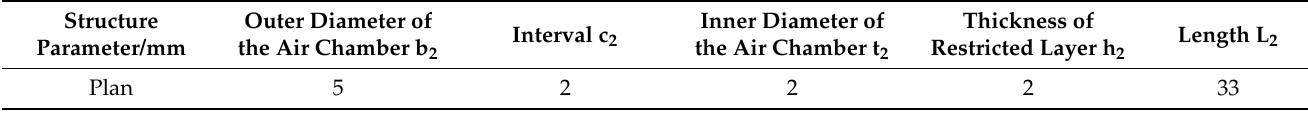
Figure 3. Structure of rotating actuators. ( a ) Rotating actuator for four fingers and ( b ) Actuator for thumb. Table 2. Structure Scheme of Thumb rotating Actuator.